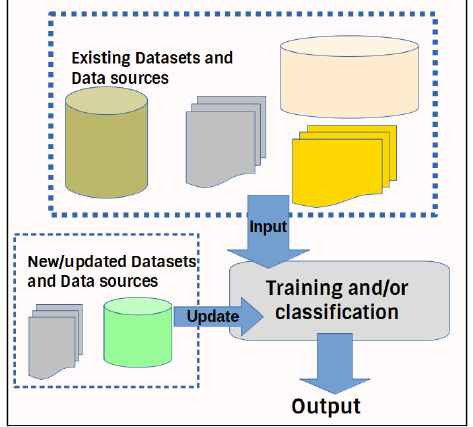
Figure 1. Overall schematic of our proposed AI-based